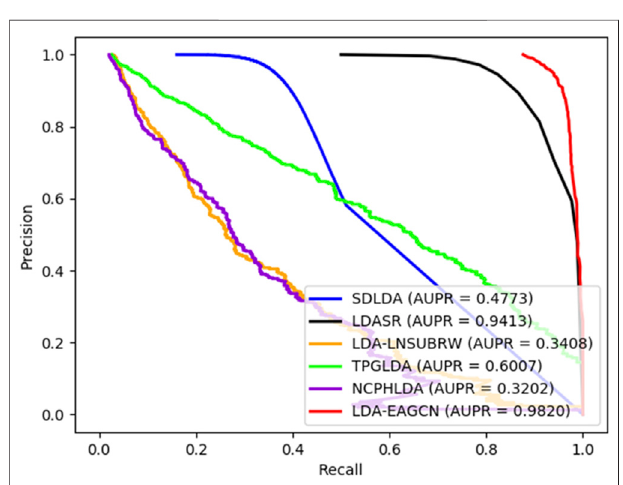
FIGURE 7 | PR curves of all the models in